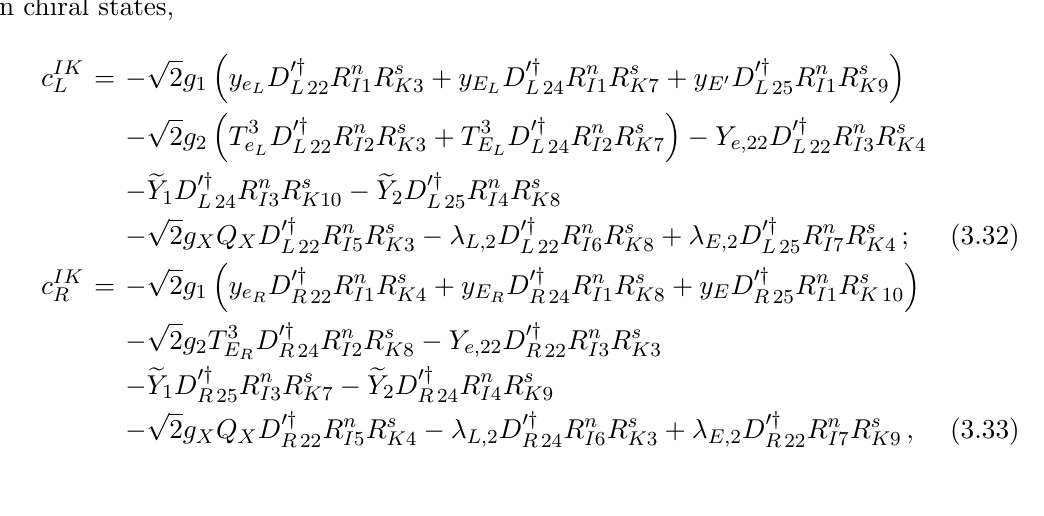
Figure 3. (a) The region of the ( M L , M E ) plane yielding (cid:14) ( g (cid:0) 2) experimental measurement at 2 (cid:27) , if only the contribution of eq. (3.31) is taken into account. In orange, (cid:21) L; 2 = (cid:21) E; 2 = 0 : 4 ; in yellow, (cid:21) L; 2 = (cid:21) E; 2 = 0 : 8 . The scalar mass and mixing parameters are (cid:12)xed to typical values featured in the legend. (b) In the ( m ~ e agreement with the measurement of (cid:14) ( g (cid:0) 2) is considered. In yellow g X = 0 : 4 and in orange g X = 0 : 8. Other relevant parameters are (cid:12)xed to the values given in the